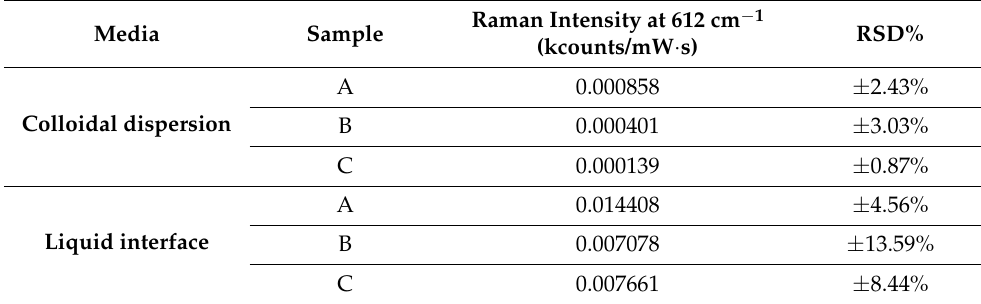
Table 2. Raman intensity and standard deviation for samples A, B, and C in dispersion and as aggregated films at the liquid-air interfacial